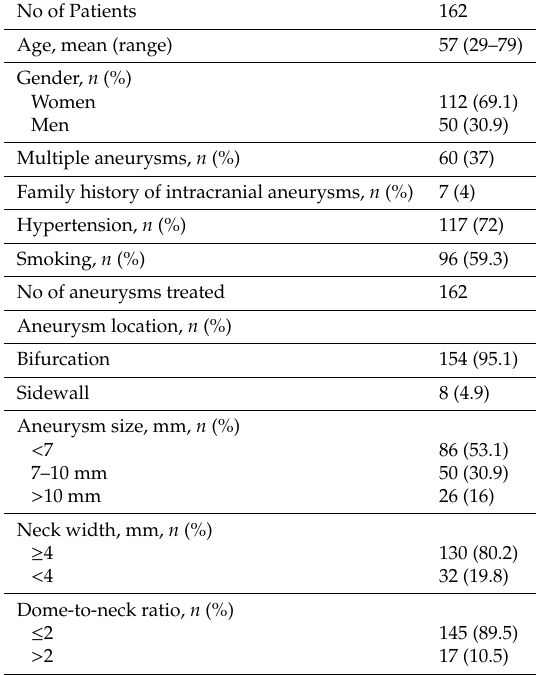
Table 1. Study population and aneurysm